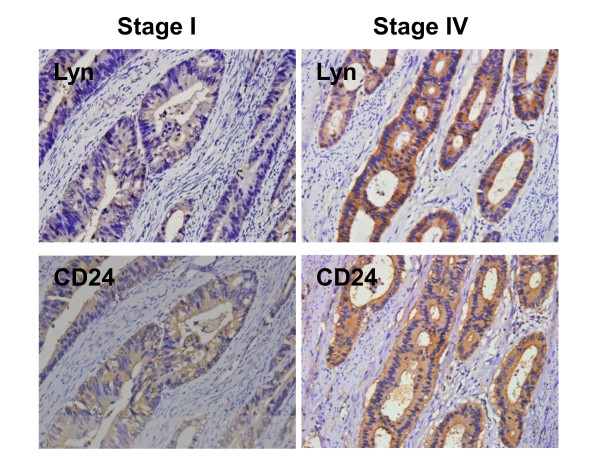
The representative pictures of immunohistochemical staining for Lyn and CD24 in serial sections of CRC tissues with different stages (left: stage I; right: stage IV). (original magnification = 400×). Lyn (upper) and CD24 (bottom) showed weak expression in primary cancer tissues (stage I) and strong expression in metastatic cancer tissues (stage IV).